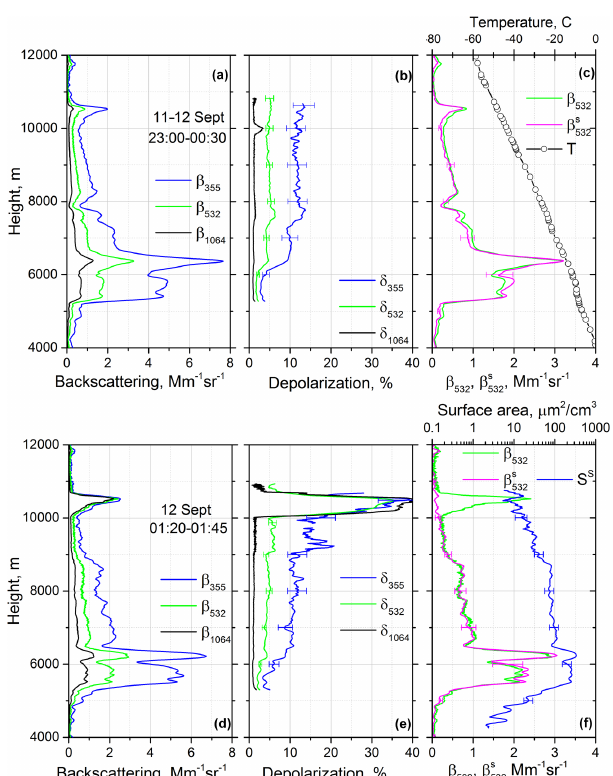
Figure 8. Formation of ice particles at 10–11km height inside a smoke layer on 11–12 September 2020. Vertical profiles of (a, d) the aerosol backscattering coefficients β 355 , β 532 and β 1064 ; (b, e) the particle depolarization ratios δ 355 , δ 532 and δ 1064 ; and (c, f) β 532 , together with backscattering coefficient of smoke β s , calculated 532 from fluorescence backscattering β F assuming G F = 4.0 × 10 − 4 . Panel (f) shows also the smoke surface area concentration S S of the smoke particles calculated from β F by applying the respective conversion factor in Eq. (3). Results are given for the time intervals 23:00–00:30 and 01:20–01:45UTC, which are prior to and during ice cloud formation at 10.5km height. The temperature profile mea- sured by the radiosonde at Herstmonceux is shown with open sym- bols in panel (c)